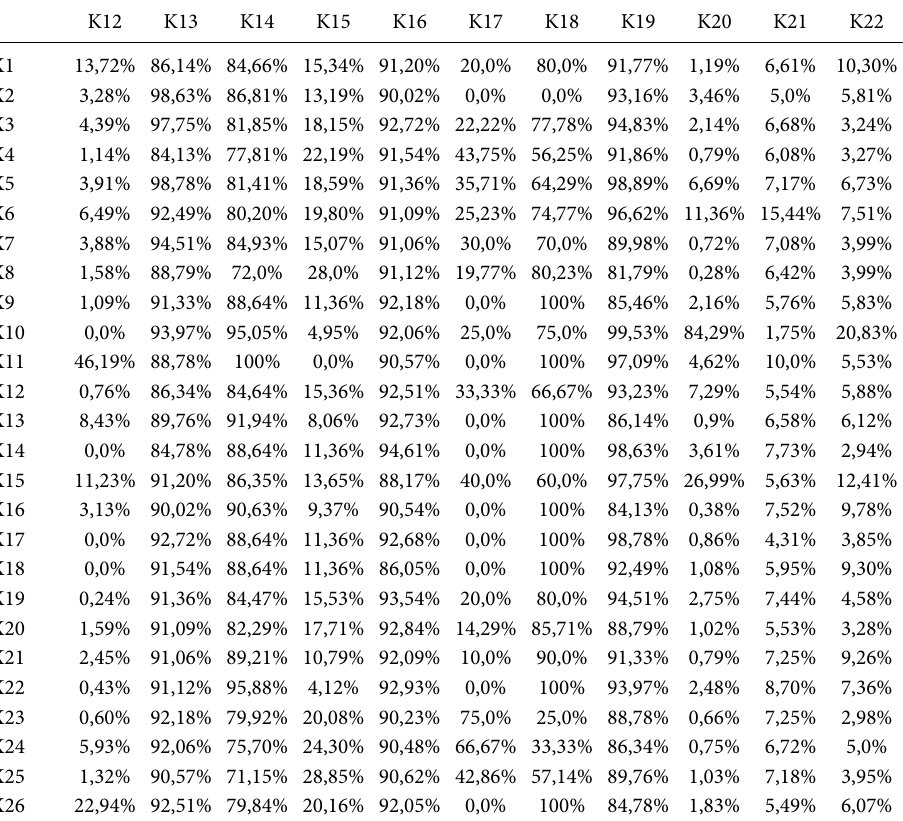
Table A2. Evaluation matrix